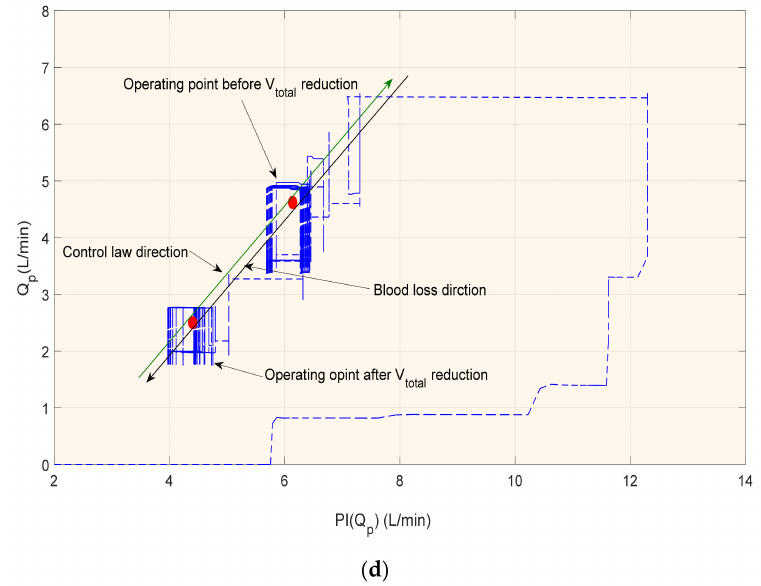
Figure 4. Hemodynamic variable results in the rest condition; ( a ) pressure–volume loops; ( b ) pump speed; ( c ) estimated flow vs. target pump flow; ( d ) pump flow pulsatility vs. estimated